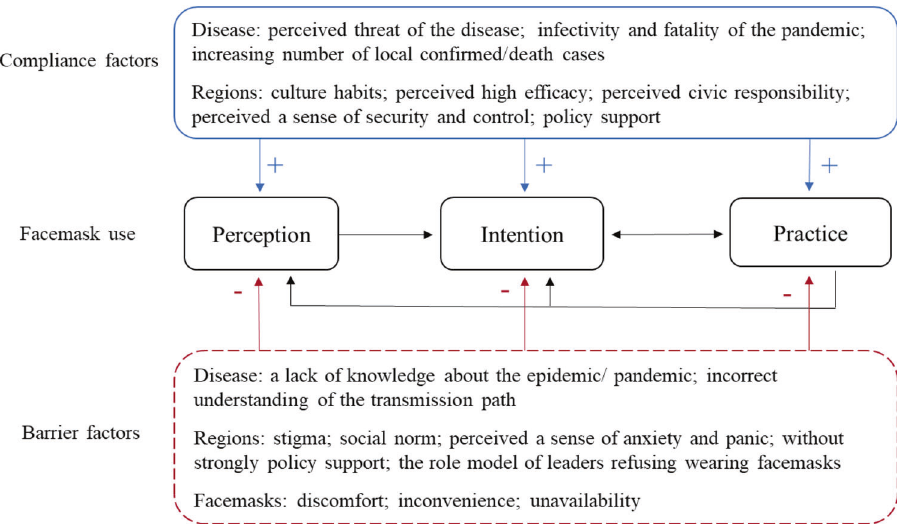
Fig. 5 The compliance related factors and barriers in the use of facemask. Factors associated with compliance of facemask use can be divided into threat of disease (e.g. perceived threat of disease) and geographic variation (e.g. perceived civic responsibility). Barrier factors of facemask use can be divided into knowledge of the diseases (e.g. a lack of knowledge of the disease), geographic variation (e.g. stigma), and feeling of facemask use (e.g.